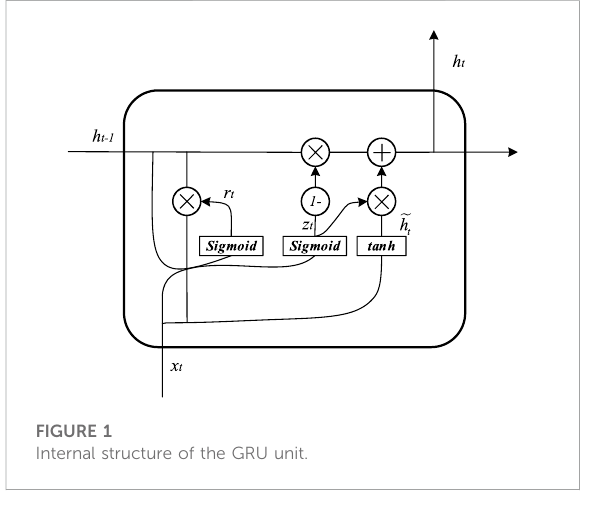
FIGURE 1 Internal structure of the GRU unit.